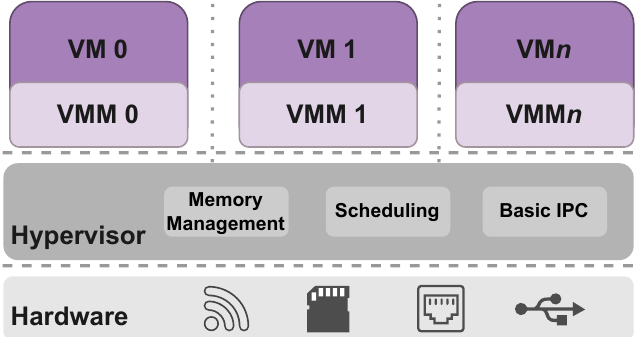
Figure 1. Overview of a virtualization environment considering seL4 type-1